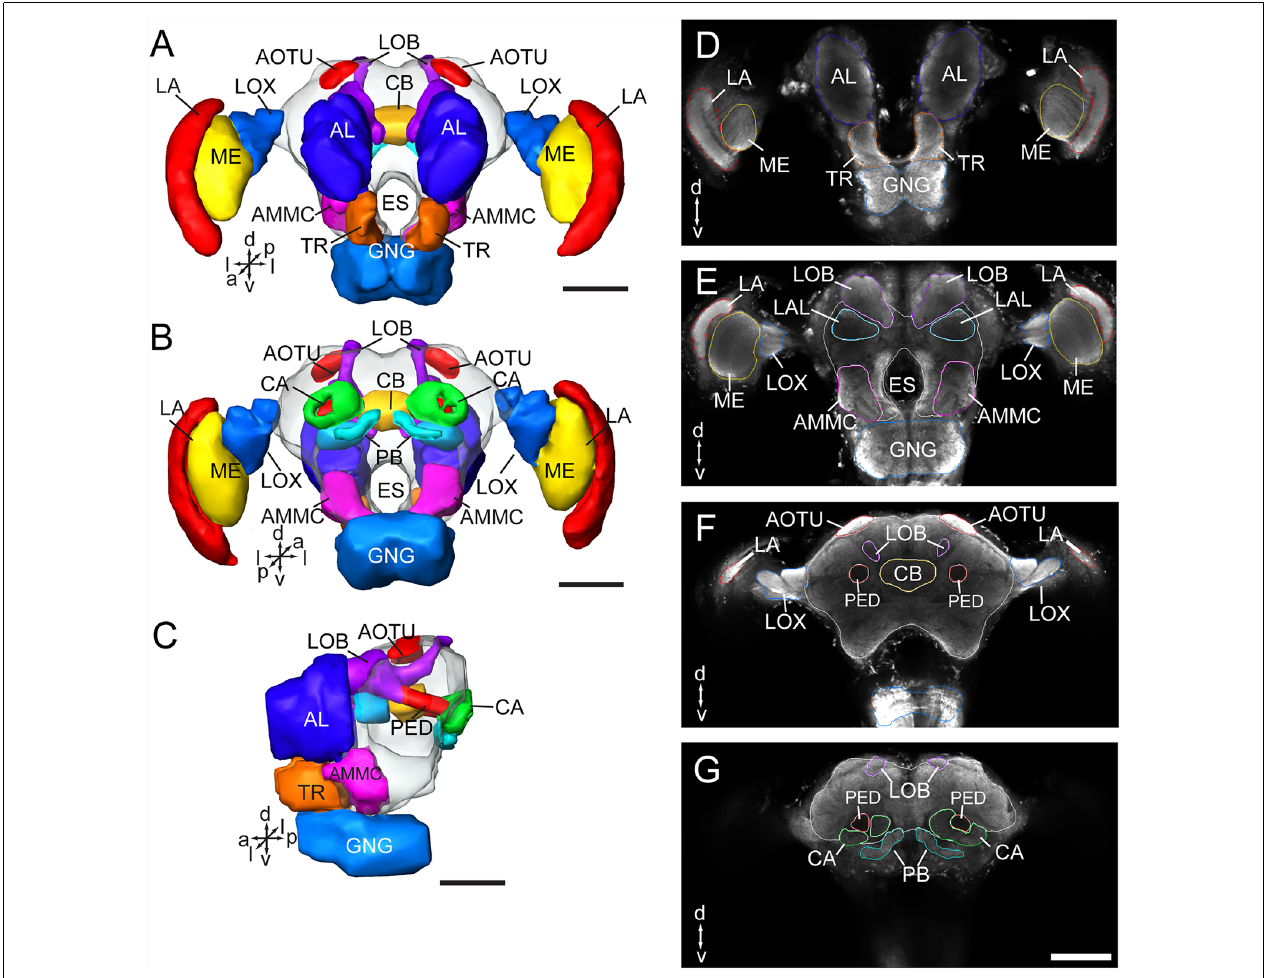
FIGURE 1 | Three-dimensional reconstructions and confocal images of the Apolygus lucorum brain. (A) Three-dimensional reconstructions of brain in frontal view. (B) Posterior view. (C) Lateral view. (D–G) Serial confocal images showing the brain sections of A. lucorum . AMMC, antennal mechanosensory and motor center; AL, antennal lobe; AOTU, anterior optic tubercle; CA, calyx; CB, central body; ES, esophagus; GNG, gnathal ganglion; LA, lamina; LOB, mushroom body lobes; LOX, lobula complex; ME, medulla; PB, protocerebral bridge; PED, pedunculus; TR, tritocerebrum. Directions: a, anterior; d, dorsal; l, lateral; m, medial; p, posterior, v, ventral. Scale bars: 100 µ